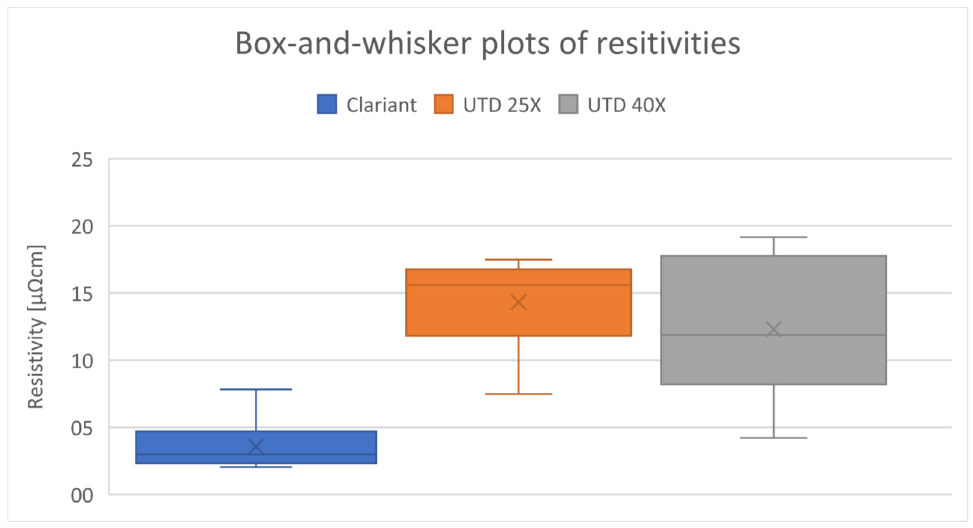
Figure 6. Box-and-whisker plots of the calculated resistivities. Table 4. Obtained resistivities for investigated inks.